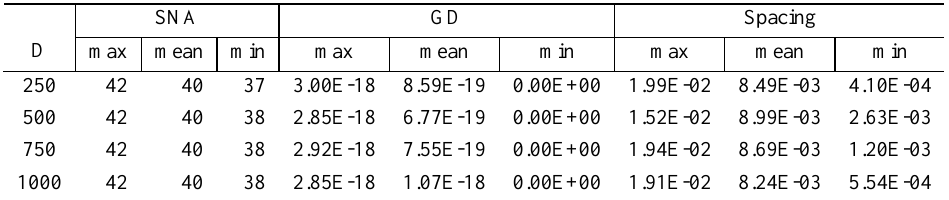
Table 2. Statistical results for ZDT1